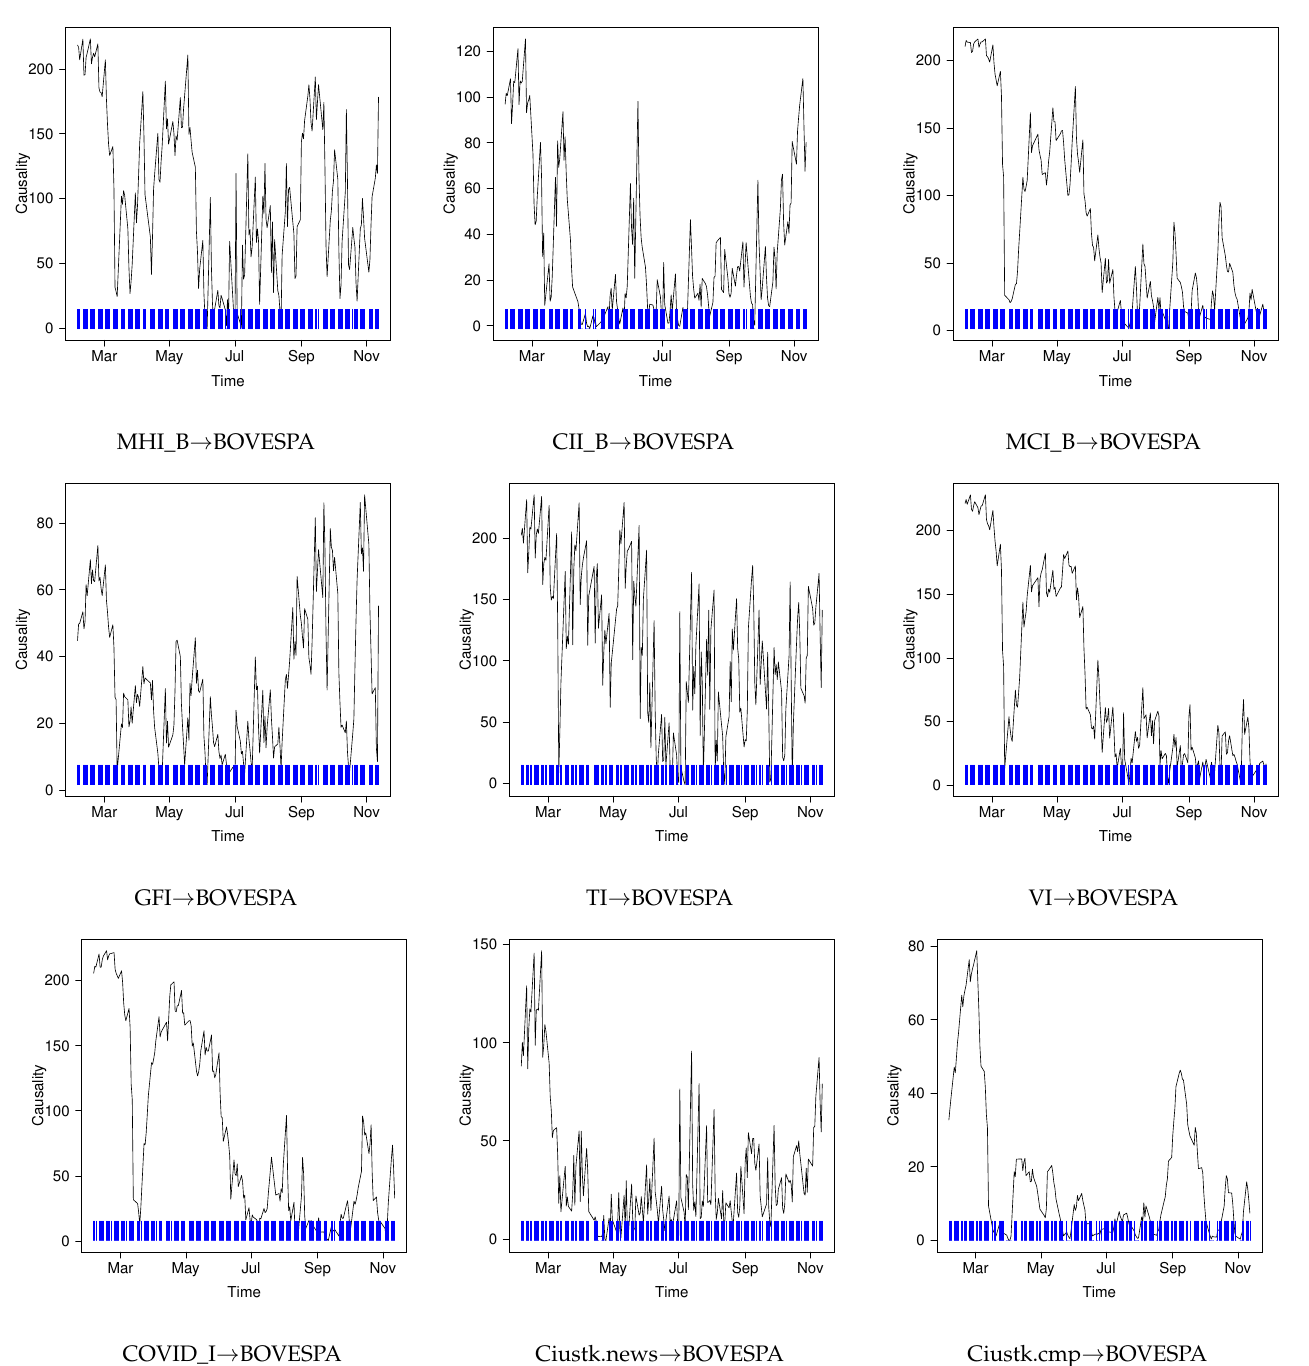
Figure 2. Instantaneous, one-way Granger-causality from news series to BOVESPA (DCC- GARCH